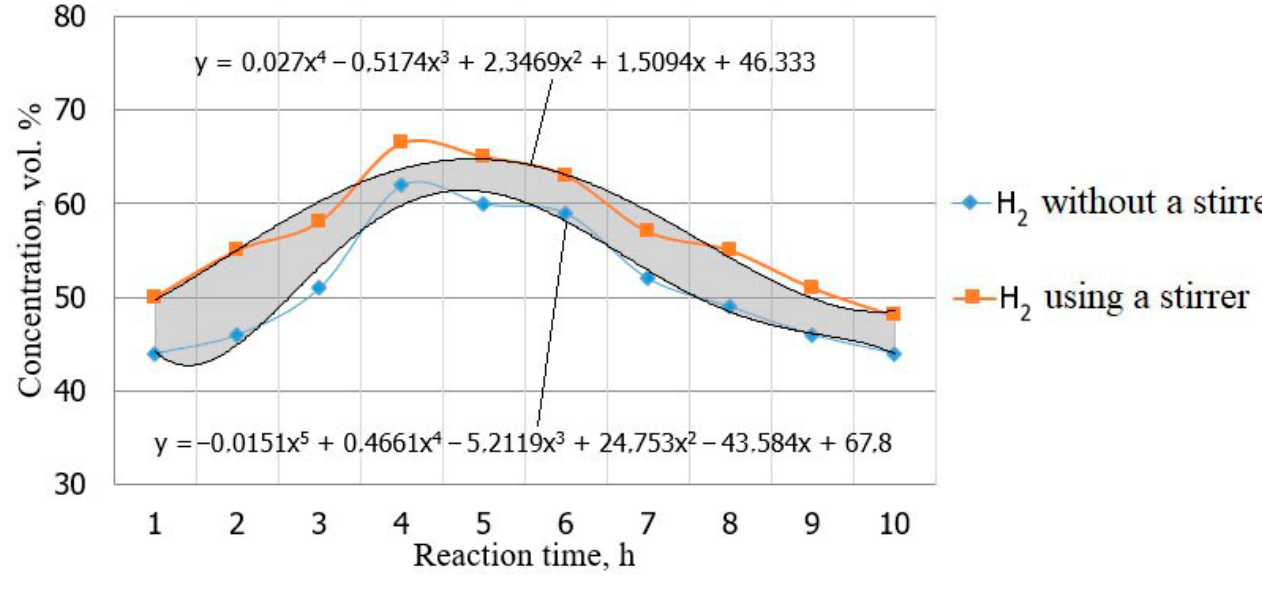
Figure 10. Approximation plots of average pyrolysis hydrogen concentration curves.